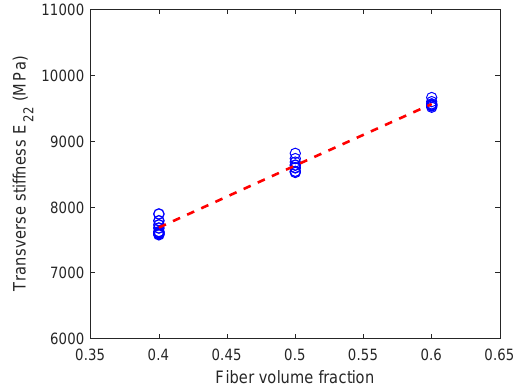
Figure 14. Variation of transverse tensile strength with unit cell size with V Waas [12]).